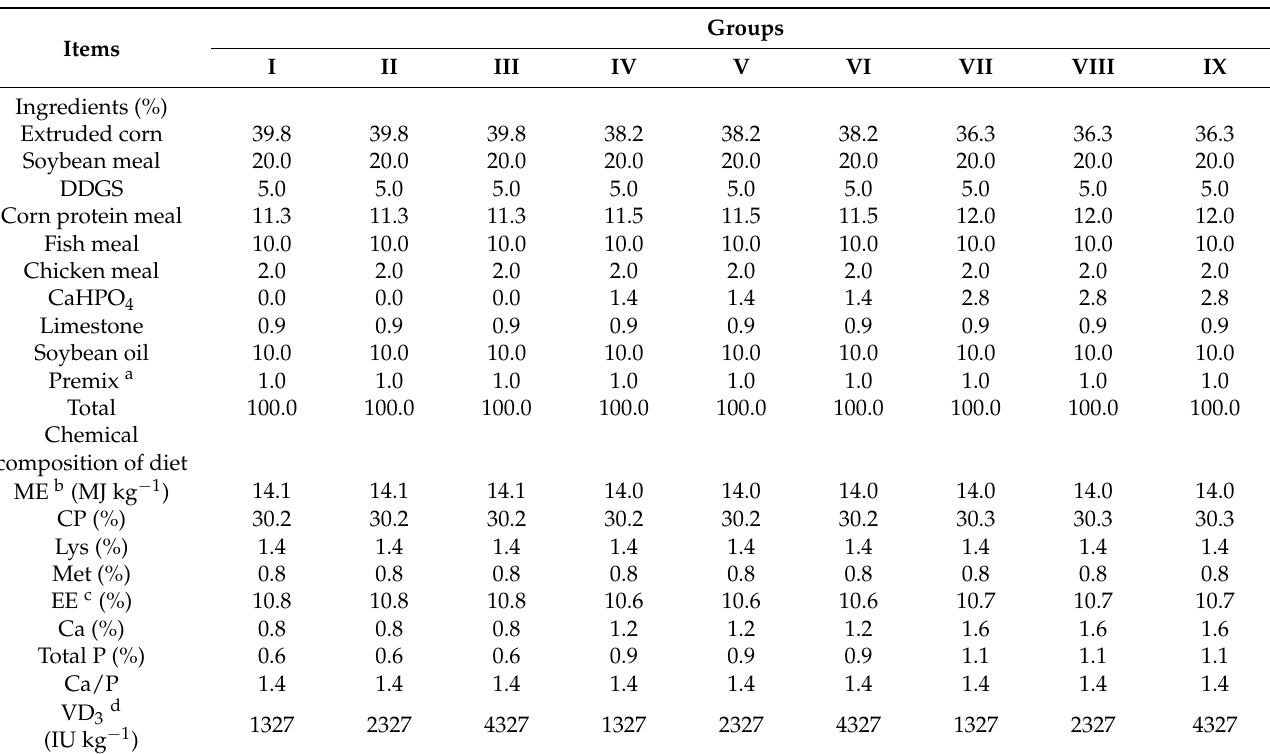
Table 1. Composition of the 9 categories of diets provided to 120-day-old maturing and furring blue foxes (air-dry